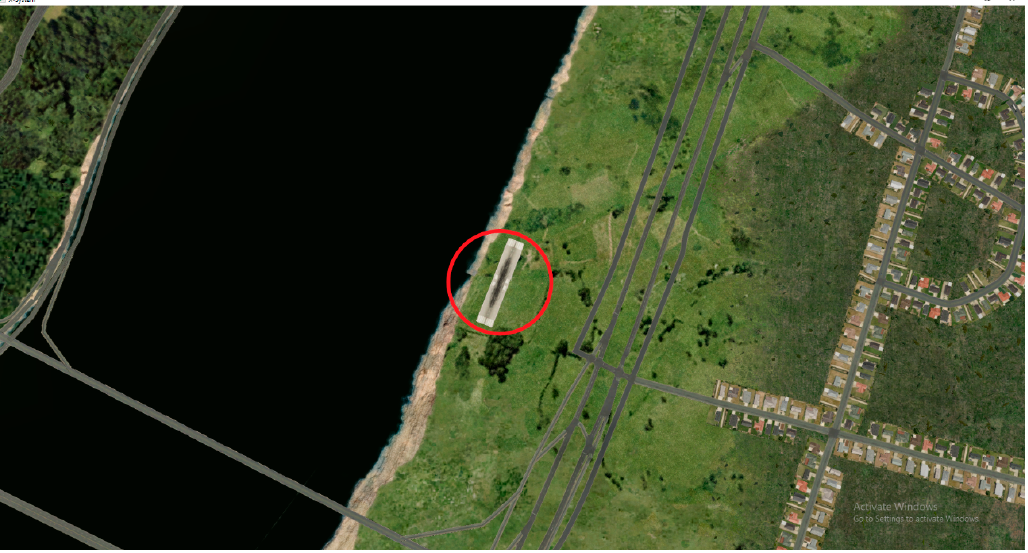
Figure 6. Designed virtual location (Hangang Drone Park) in X ‐ Plane.